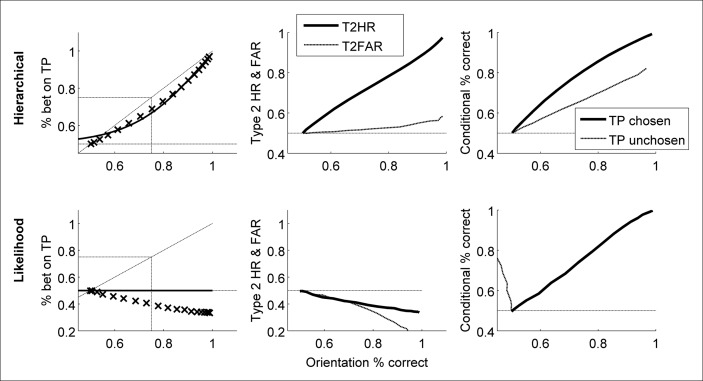
Sample of predicted behavior from Alternative Models 1 (Heuristic - hierarchical Inference) and 2 (Heuristic - likelihood comparison) (at θ = 90º; see above).While the hierarchical observer produces behavior similar to the ideal observer, the likelihood comparison strategy does not.